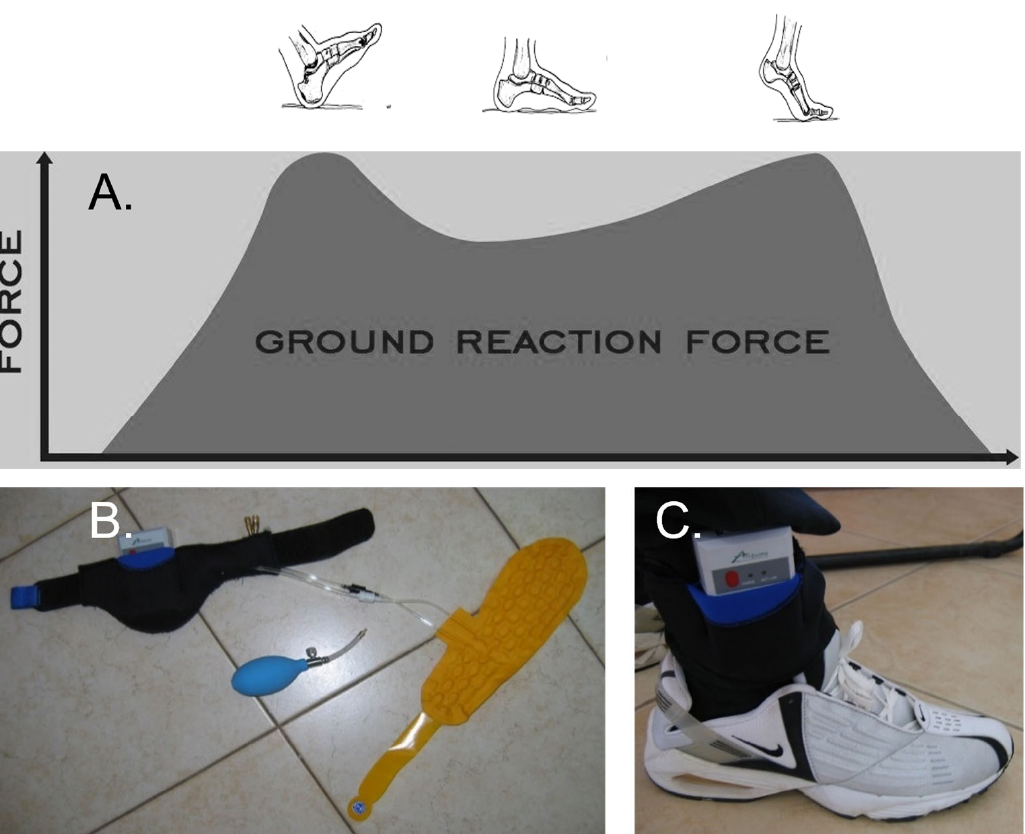
Figure 1. Ground reaction forces during normal gait (a butterfly diagram) and digital gait analysis tool. ( A ) The force is minimal at heel-strike, rises to a maximum soon after, falls a bit during the middle stance, rises again at toe-off, and finally falls to complete the gait cycle. ( B ) The SmartStep™ Gait System insole, Andante Medical Devices (Israel). The tool comprises the insole (yellow) with two sensors; the pump inflates the insole and the central processing unit to record gait parameters. ( C ) The insole was inserted into a shoe, and a participant wore the whole assembly.